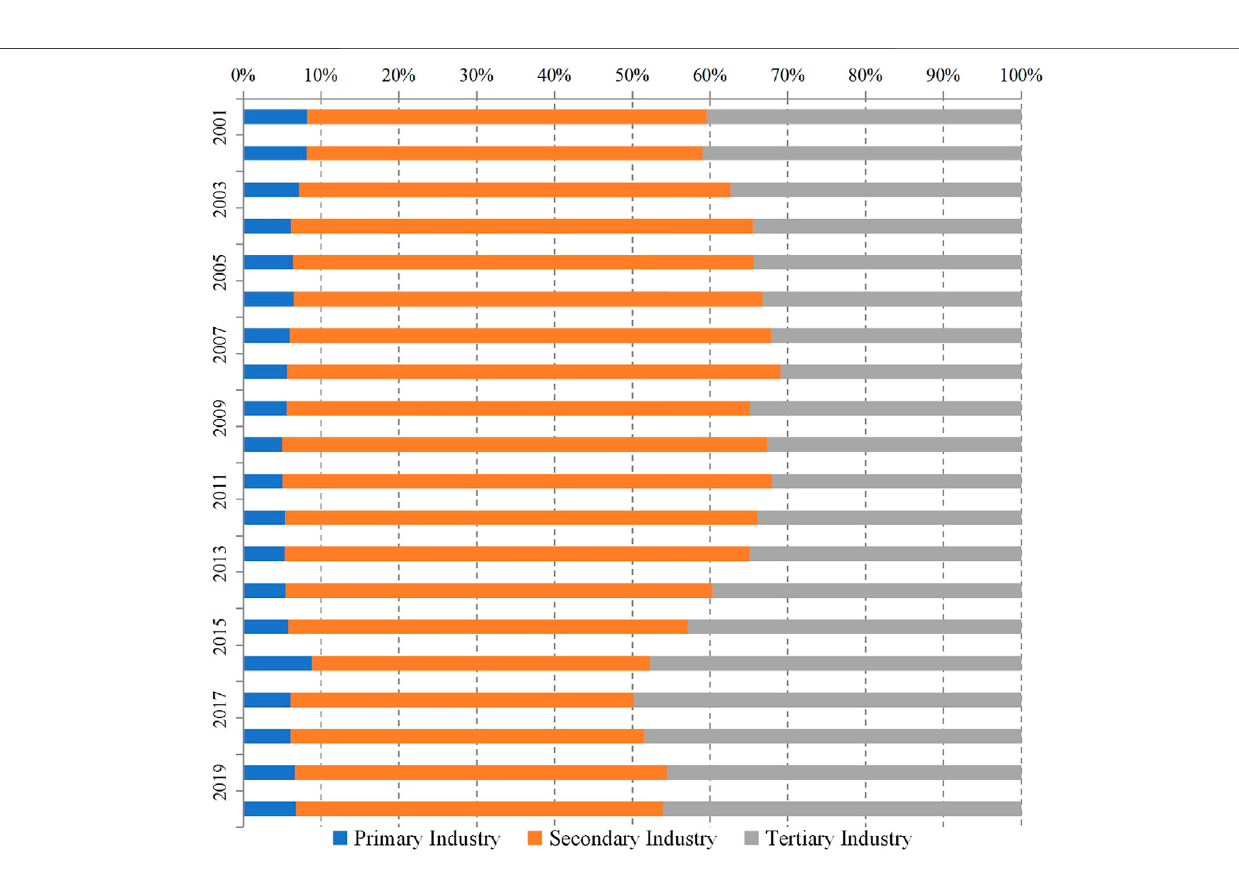
Frontiers in Environmental Science |